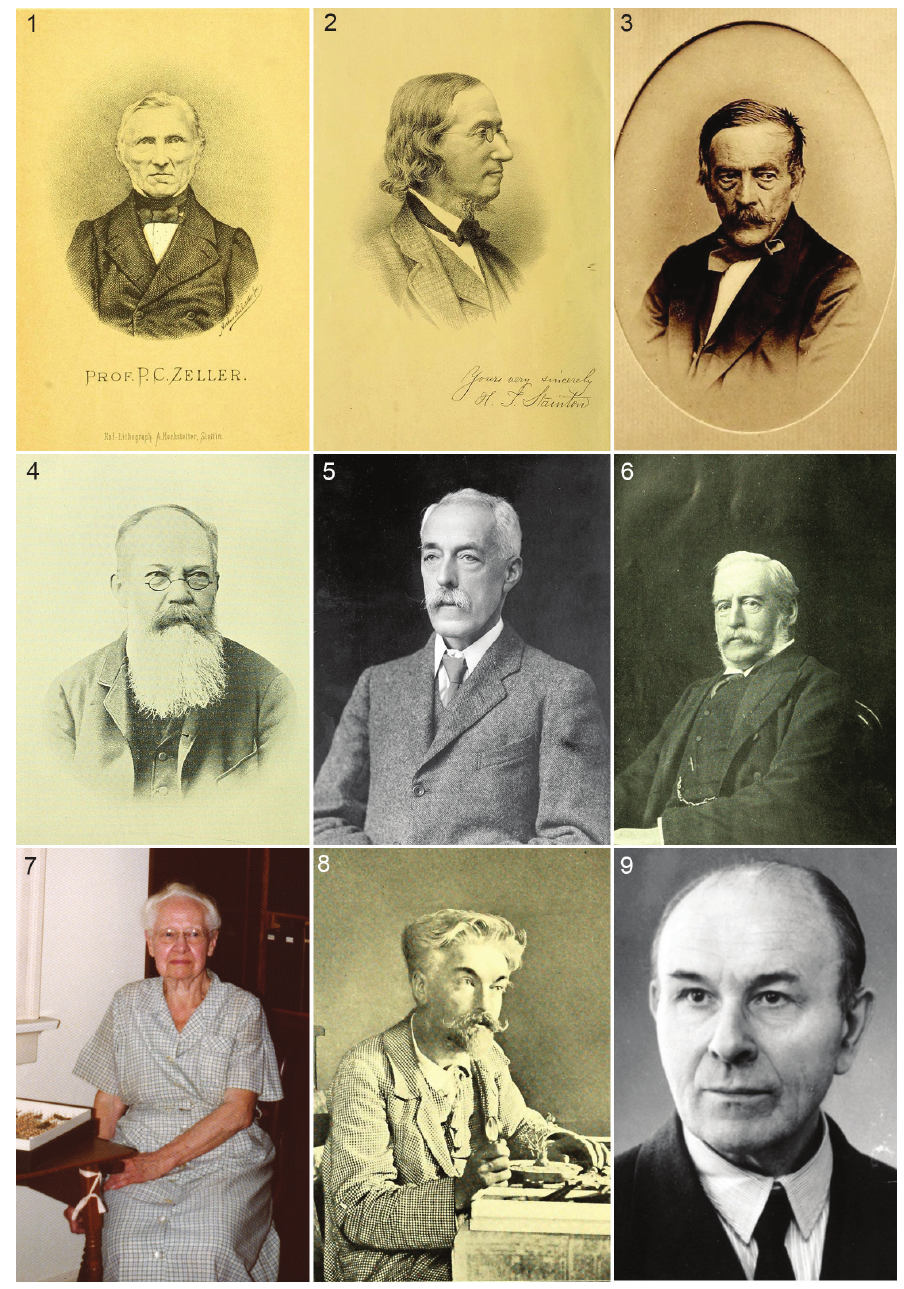
Figures 1–9. Portraits of Lepidopterists who described Nepticuloidea. 1 Philipp Christoph Zeller (Stainton 1883) 2 Henry Tibats Stainton from Douglas and Mclachlan (1893) 3 Gottlieb August Wil- helm Herrich-Schäffer, ca 1870 (Kraatz 1875) 4 Maximilian Ferdinand Wocke (Dittrich 1907) 5 Edward Meyrick (Clarke 1955) 6 Lord Walsingham (Durrant 1920) 7 Annette Francis Braun, in 1973 in her home in Cincinnati, Ohio (photo Mignon Davis) 8 Pierre Chrétien, Digne, May 1903 (Oberthür 1915) 9 Erich Martin Hering. Figs 1–6 and 8 from Biodiversity Heritage Library, 9 from